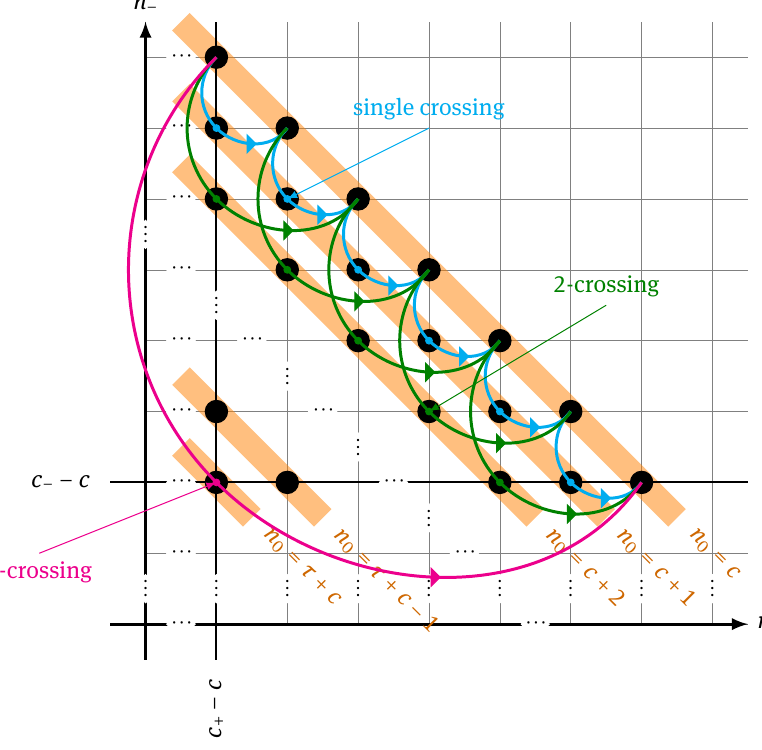
Figure 2: The lattice for a connected signed graph G on n vertices with flexibility τ , c + connected components of G + and c − connected components of G −